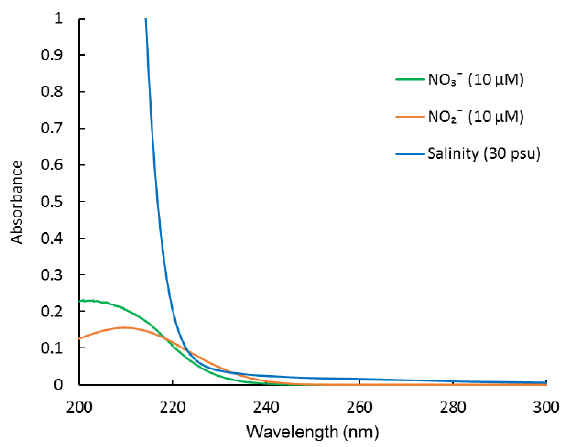
Figure 1. Absorption spectra of NO 3 − , NO 2 − , and sea salt